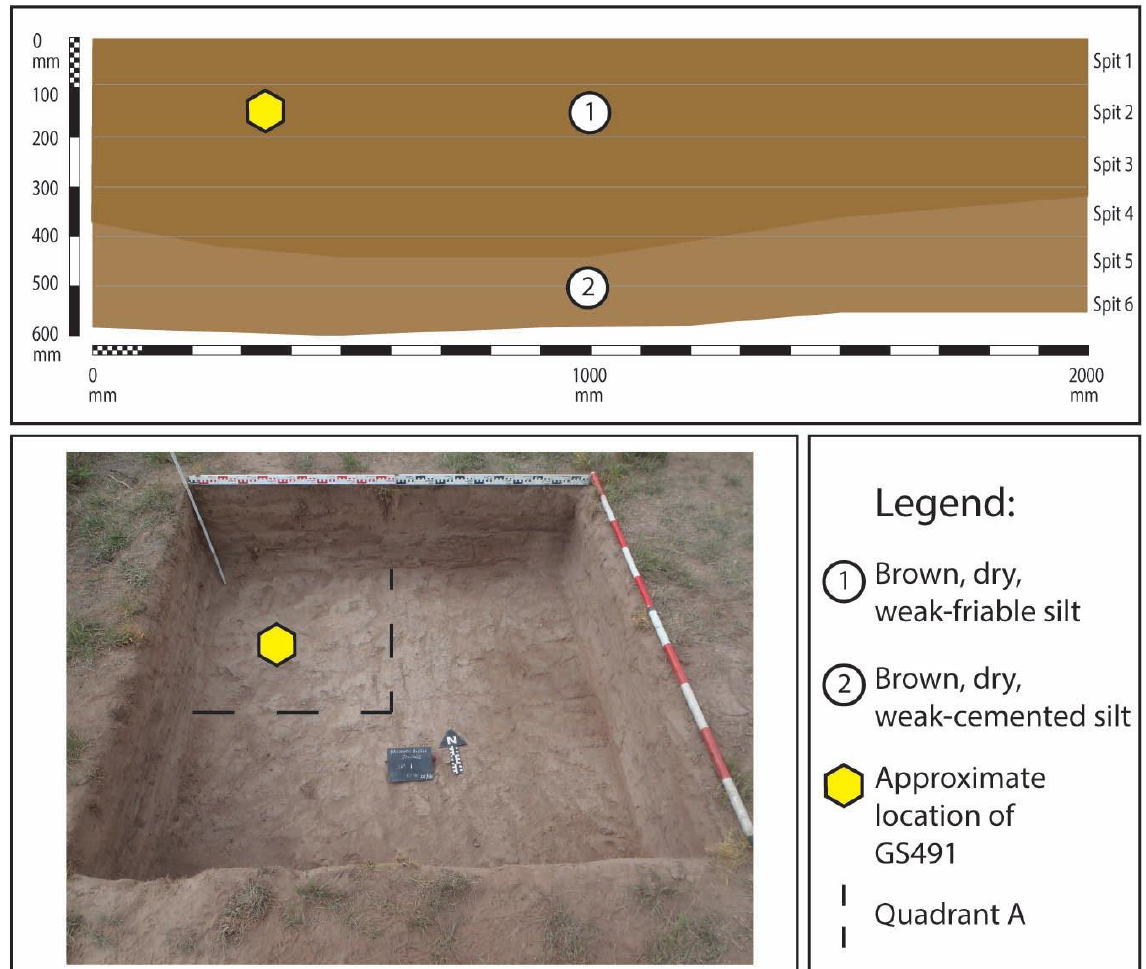
Figure 2. Upper, Stratigraphic profile of Salvage Excavation Pit 1. Lower, Base of Salvage Excavation